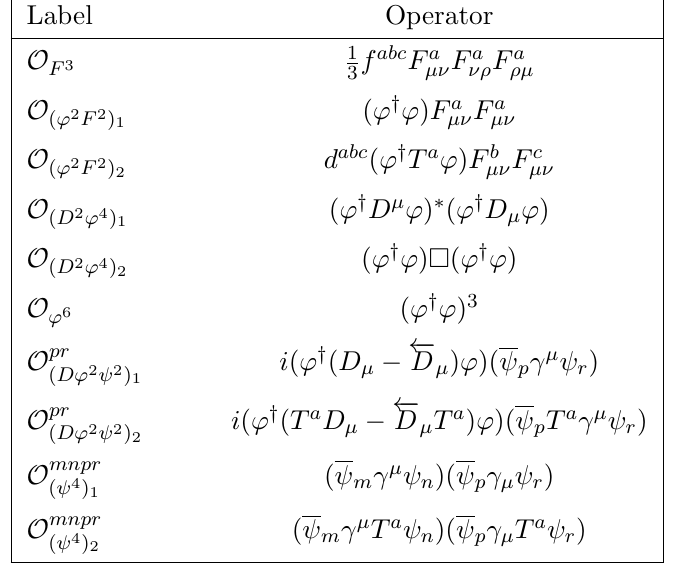
Table 1 . List of dimension-six operators considered here. For simplicity, we take the fermions to be Dirac. The labels mnpr are (cid:13)avor indices and abc color indices. Note the operator O is normalized slightly di(cid:11)erently than in refs. [4{6], as are the color matrices T a in the operators O and O . We will occasionally drop the ( ) 1 and ( ) 2 subscripts to refer to pairs of ( D’ 2 2 ) 2 ( 4 ) 2 operators